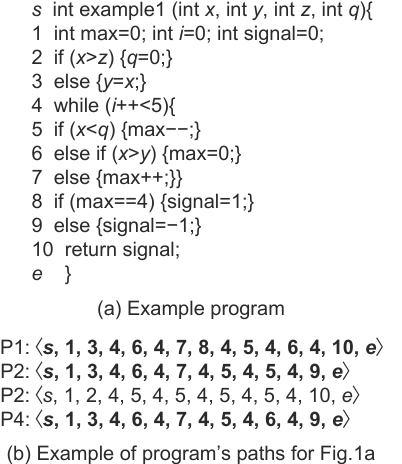
Fig. 1 Example of a program with infeasible